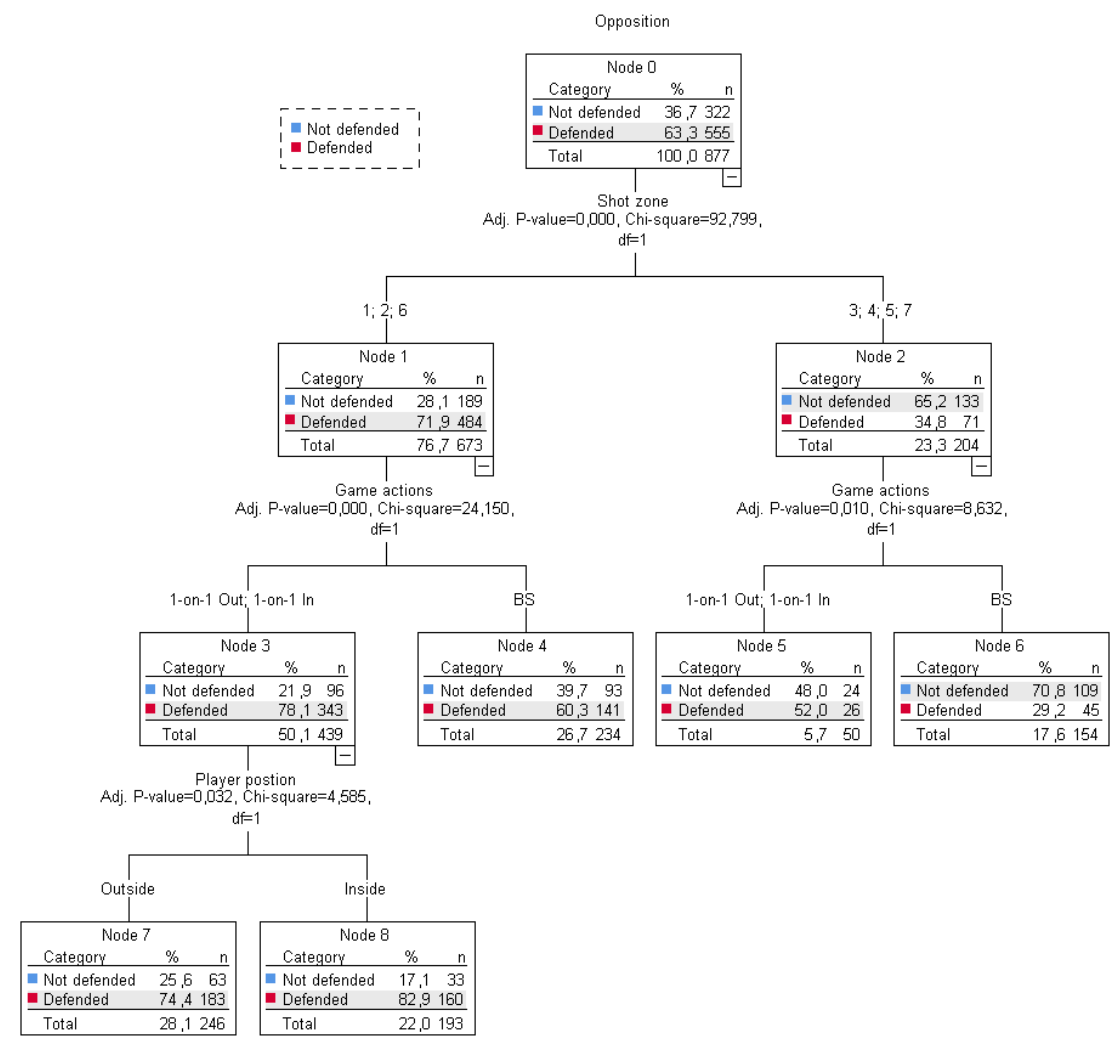
Figure 4. Shot zone, game actions (1-on-1, BS) and player position as predictive variables in the level of opposition in the shot.